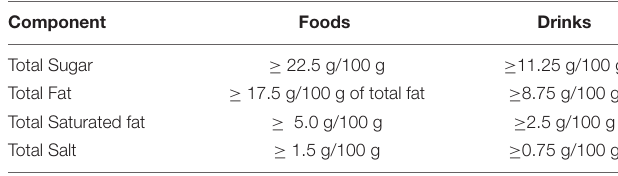
TABLE 1 | Cut-off points for fat, salt, and sugar from the current United Kingdom Guide to creating a front of pack (FoP) label.